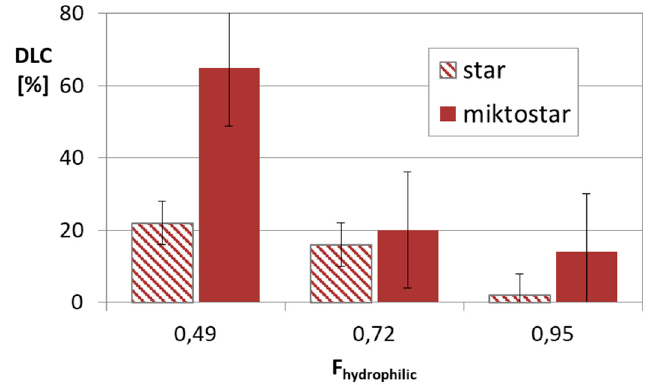
Figure 5. Drug content in micellar systems based on amphiphilic star (DGL3 series) and miktostar (DGL4 series) copolymers, where F hydrophilic is average value for comparable pair of star and miktostar.